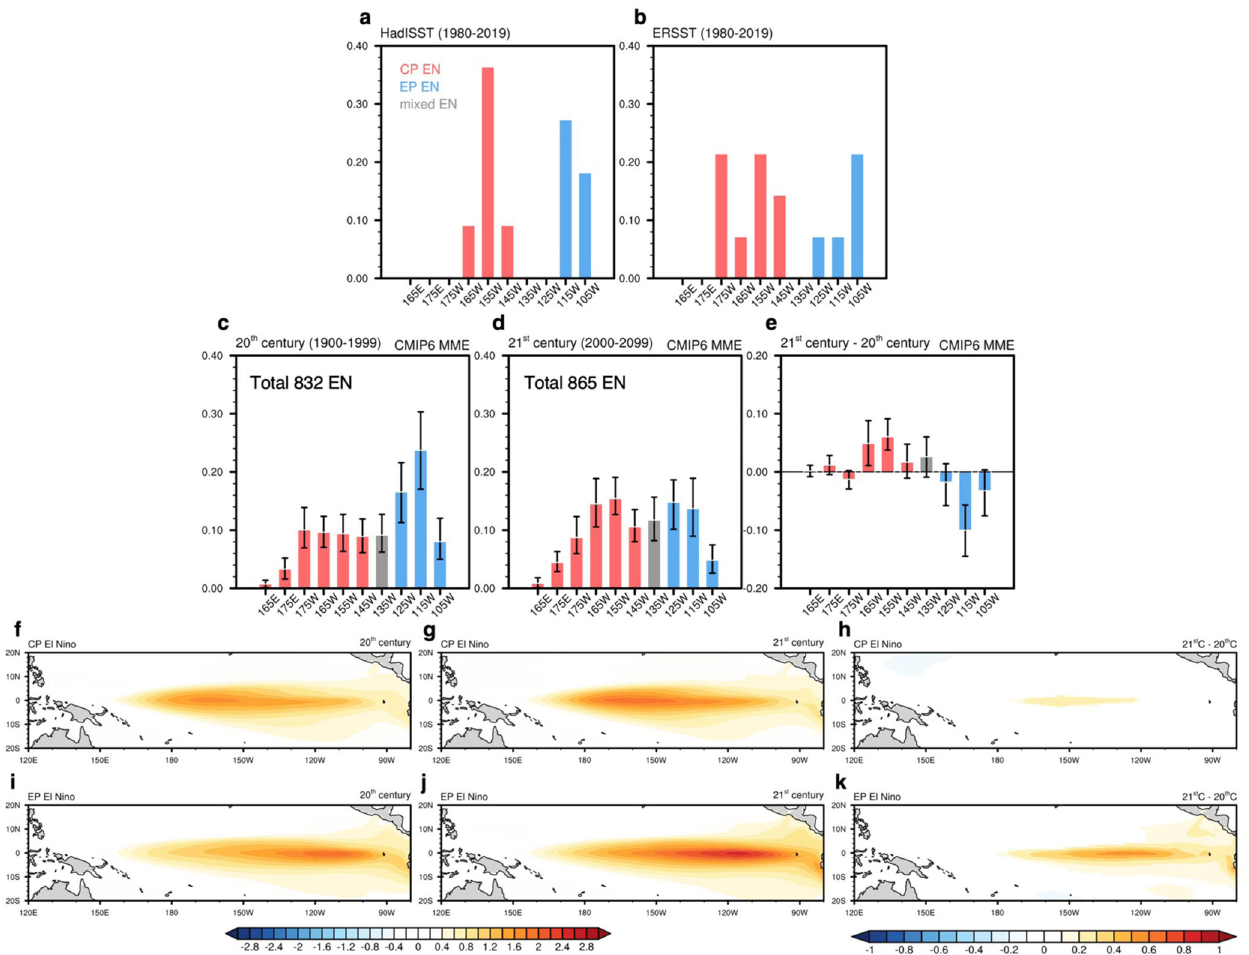
Fig. 1 Longitudinal distribution of El Niño SSTA center and its projected changes in the 21st century. a – e Histograms (normalized occurrences) of El Niño SSTA centers during November – December – January (NDJ) for ERSST ( a ), HadISST ( b ), as well as the MME of 30 CMIP6 models during the 20th century (1900 – 1999) ( c ), 21st century (2000 – 2099) ( d ), and their difference ( e ). Red, blue, and gray bars denote CP El Niño, EP El Niño, and mixed-type El Niño events, respectively. Error bars indicate the 95% con fi dence level obtained using the bootstrap method (Methods). f – k SSTA spatial patterns of each El Niño type in the CMIP6 MME: CP El Niño in the 20th century ( f ), 21st century ( g ), and difference ( h ). EP El Niño in the 20th century ( i ), 21st century ( j ), and difference ( k ). Values shown in shading are statistically signi fi cant at the 95% con fi dence level using the bootstrap method. The units are [ °C ] for ( f – k